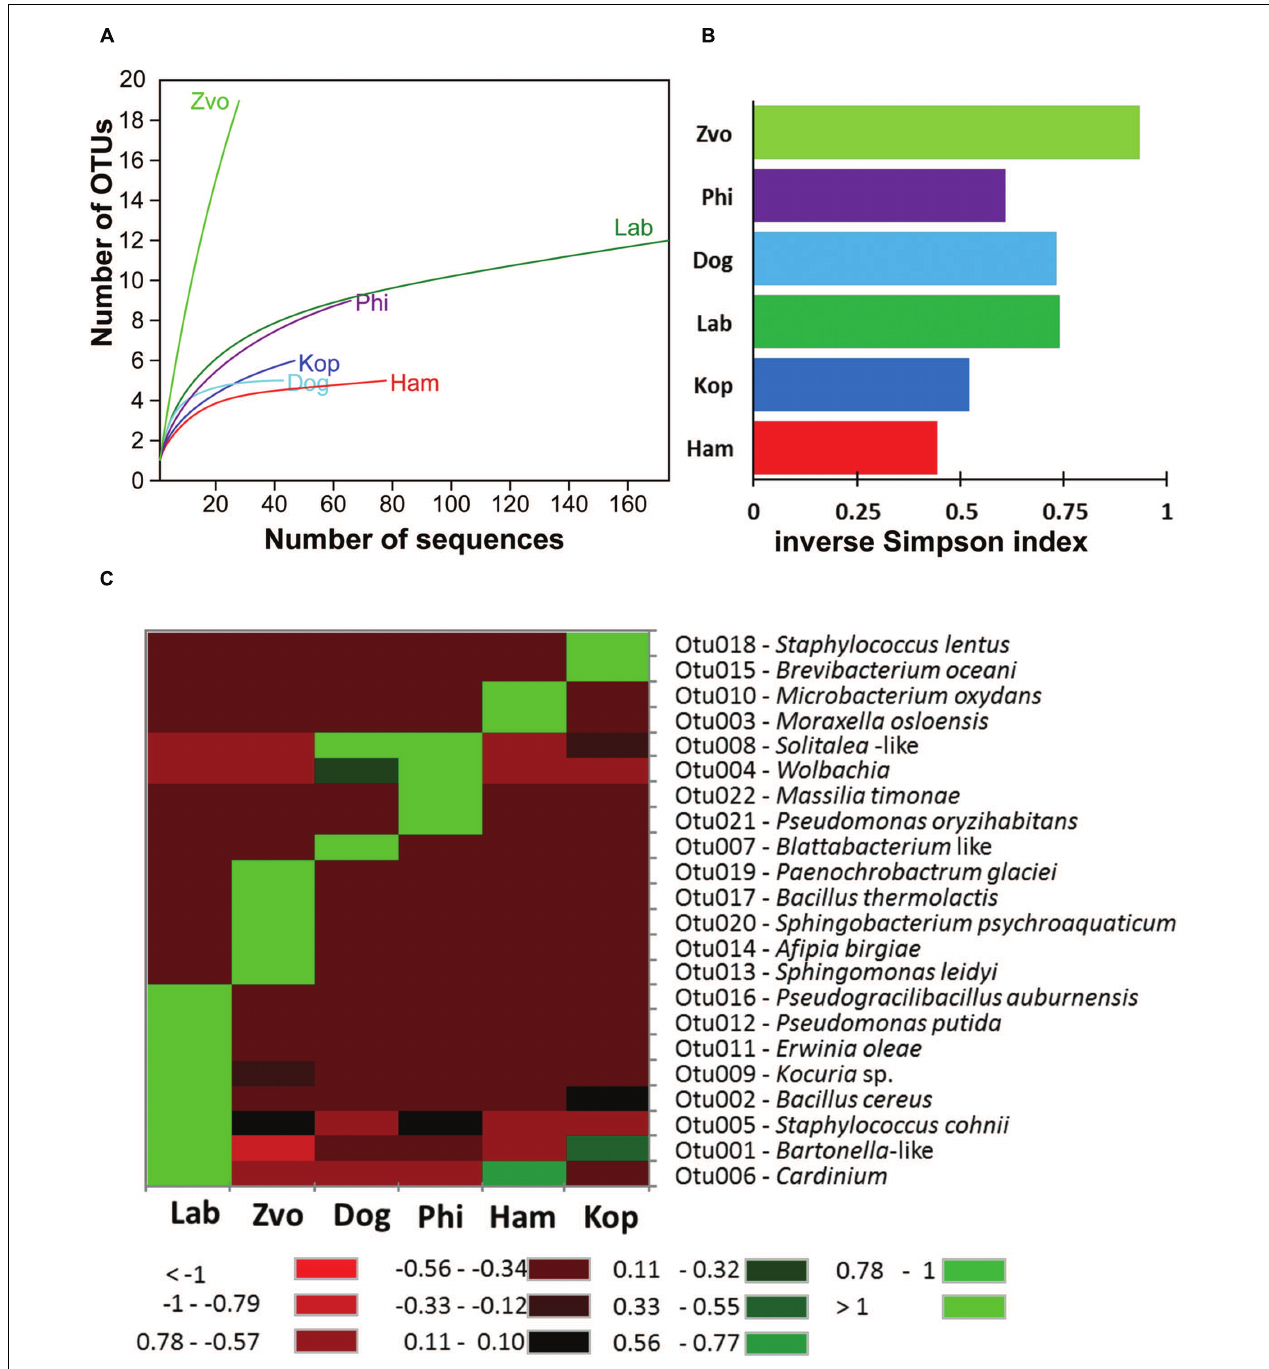
FIGURE 5 | The diversity and composition of bacterial communities in T. putrescentiae populations based on Sanger sequencing of the 16S rRNA gene clones, the amplicons originated from eubacterial primers (F24/R1492): (A) rarefaction analyses, (B) inverse Simpson diversity index, (C) heat map. Abbreviations for the T. putrescentiae populations are listed in Table 1